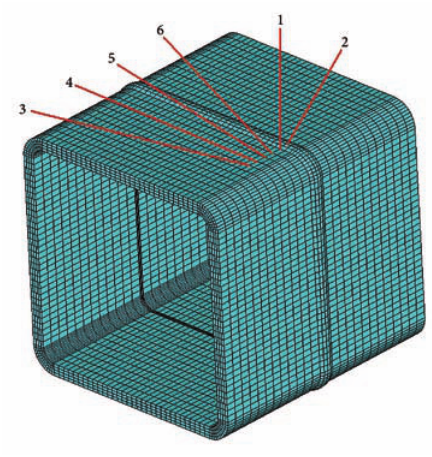
Fig. 8. Set control points (1–6) for temperature distribution